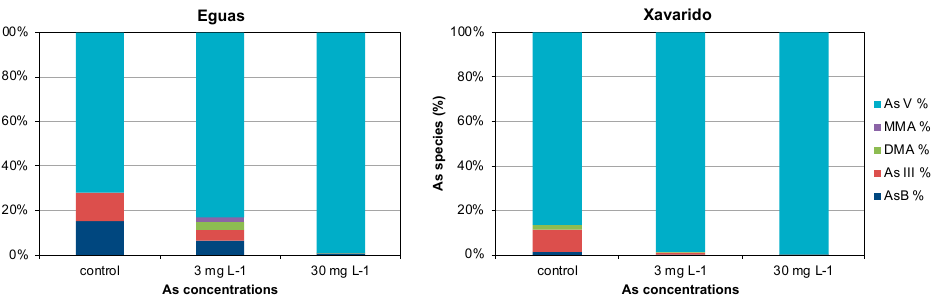
Figure 5. Speciation of As in control, 3 and 30 mg As L − 1 at day 42 from Eguas and Xavarido systems.